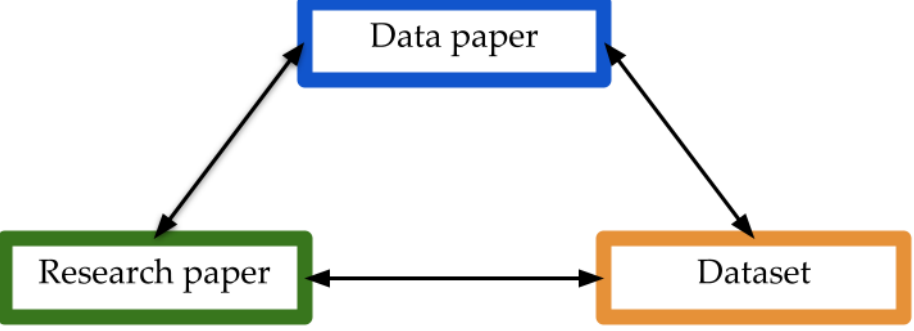
Figure 2. The triangle of “deep impact” in data-driven projects.